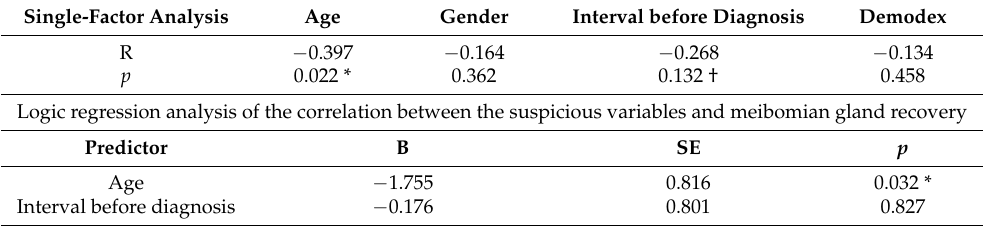
Table 2. Correlation Between the Level of Meibomian Gland Recovery and Other